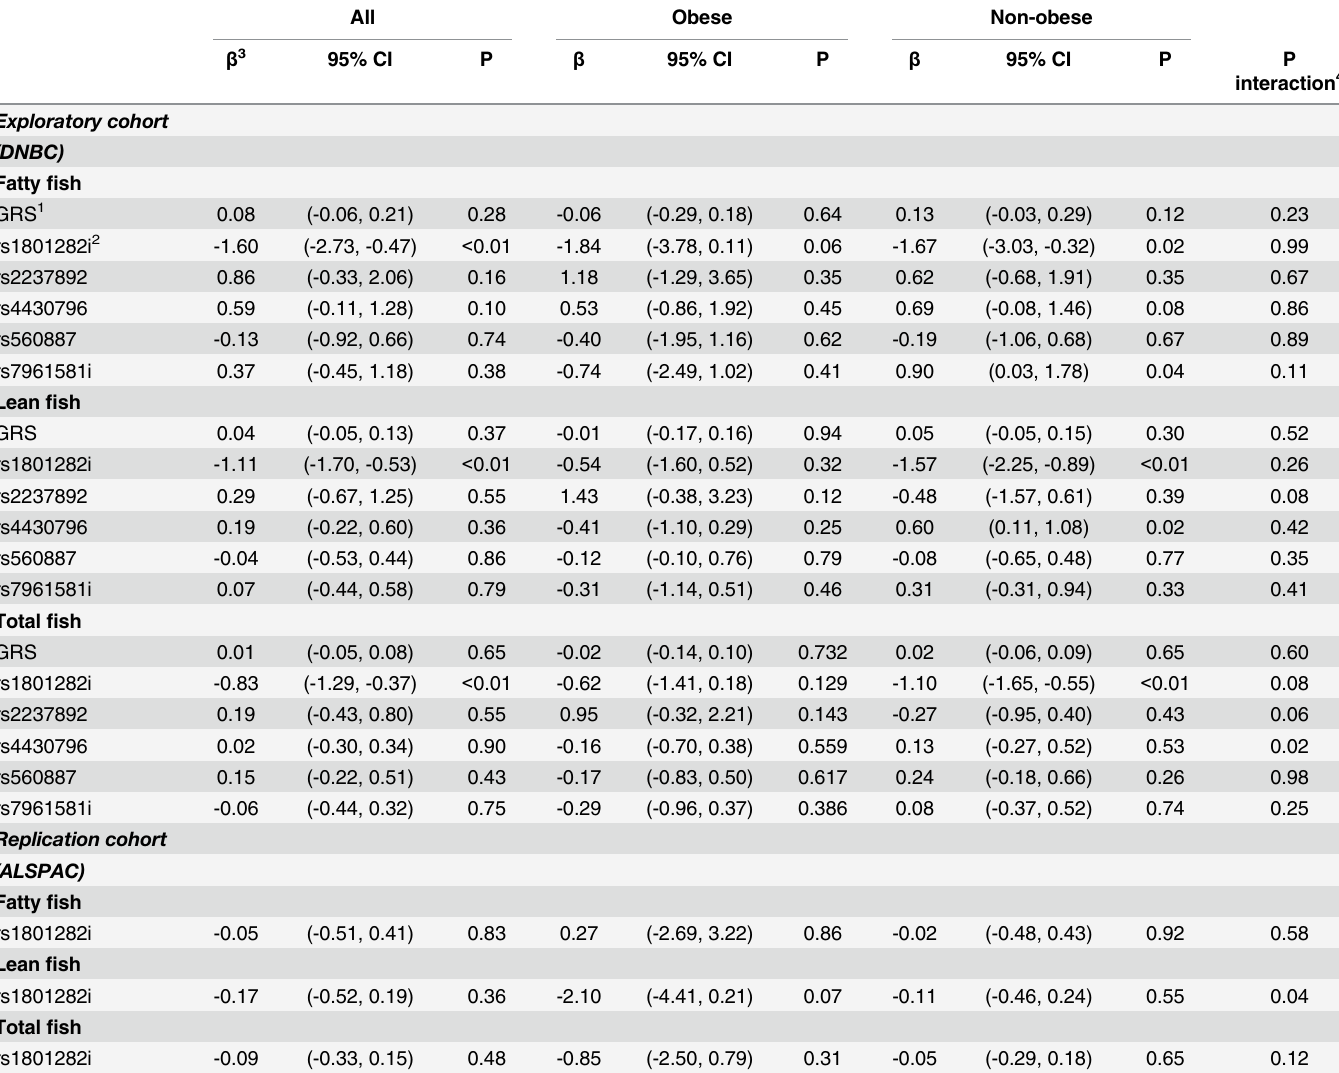
Table 4. Gene × fish interactions in relation to gestational weight gain, presented in kg per additional risk allele for each weekly serving of fish. All